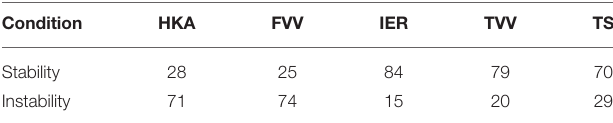
TABLE 1 | Stability/Instability class definitions according to the thresholds for the five clinical